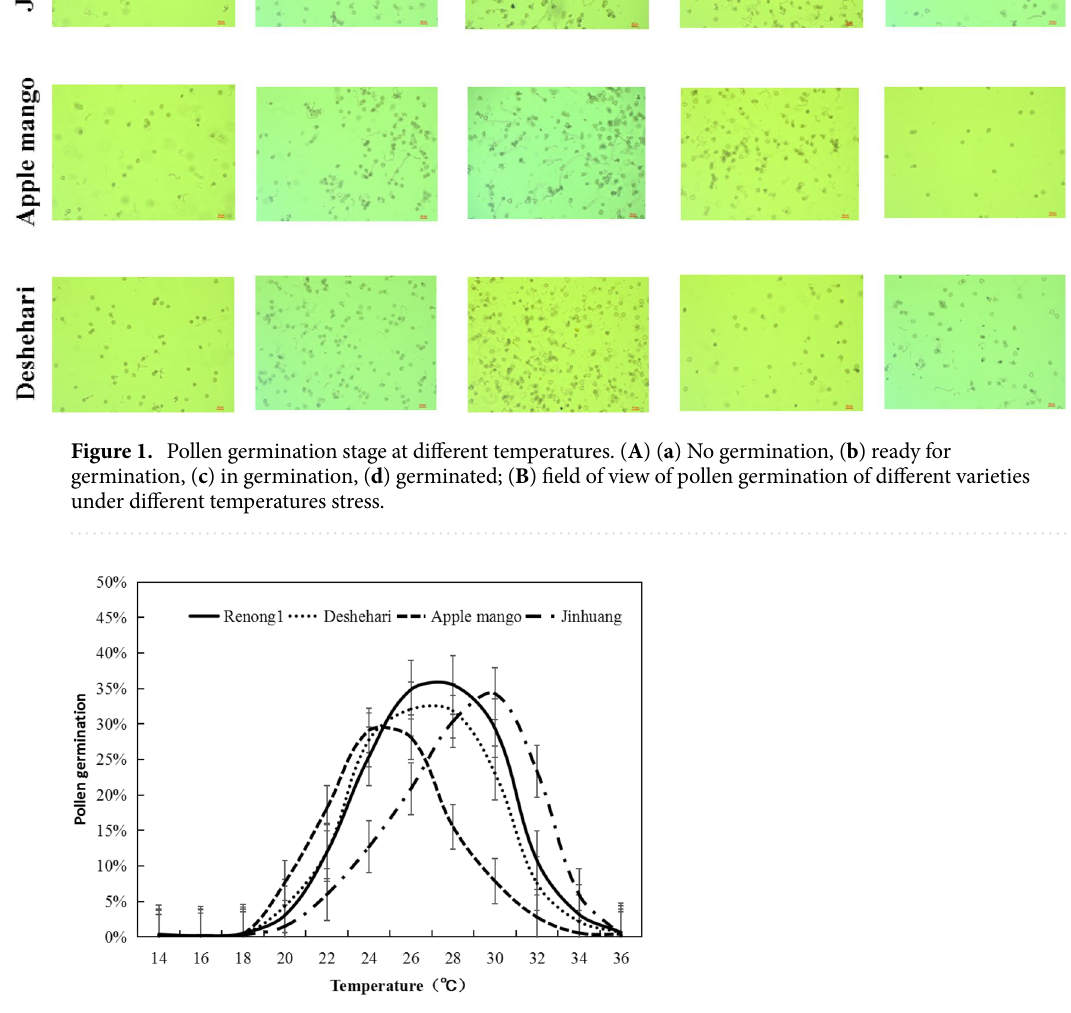
Figure 2. Pollen germination of four mango genotypes in response to different temperature